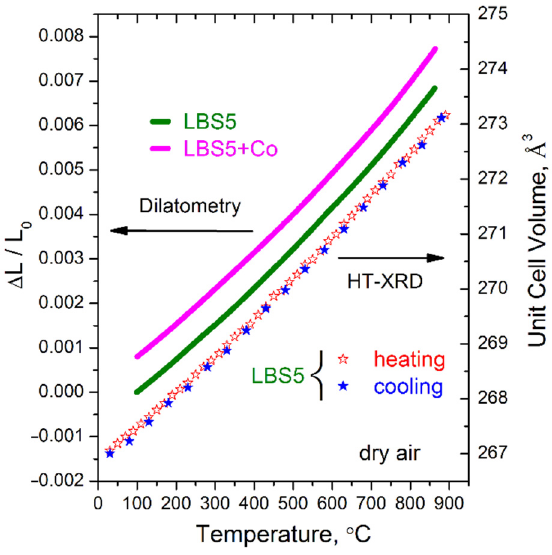
Figure 9. Thermal expansion of La 0.95 Ba 0.05 ScO 3- δ and La 0.95 Ba 0.05 ScO 3- δ + 0.5 wt% Co 3 O 4 ceramic samples in dry air according to dilatometry and HT-XRD.